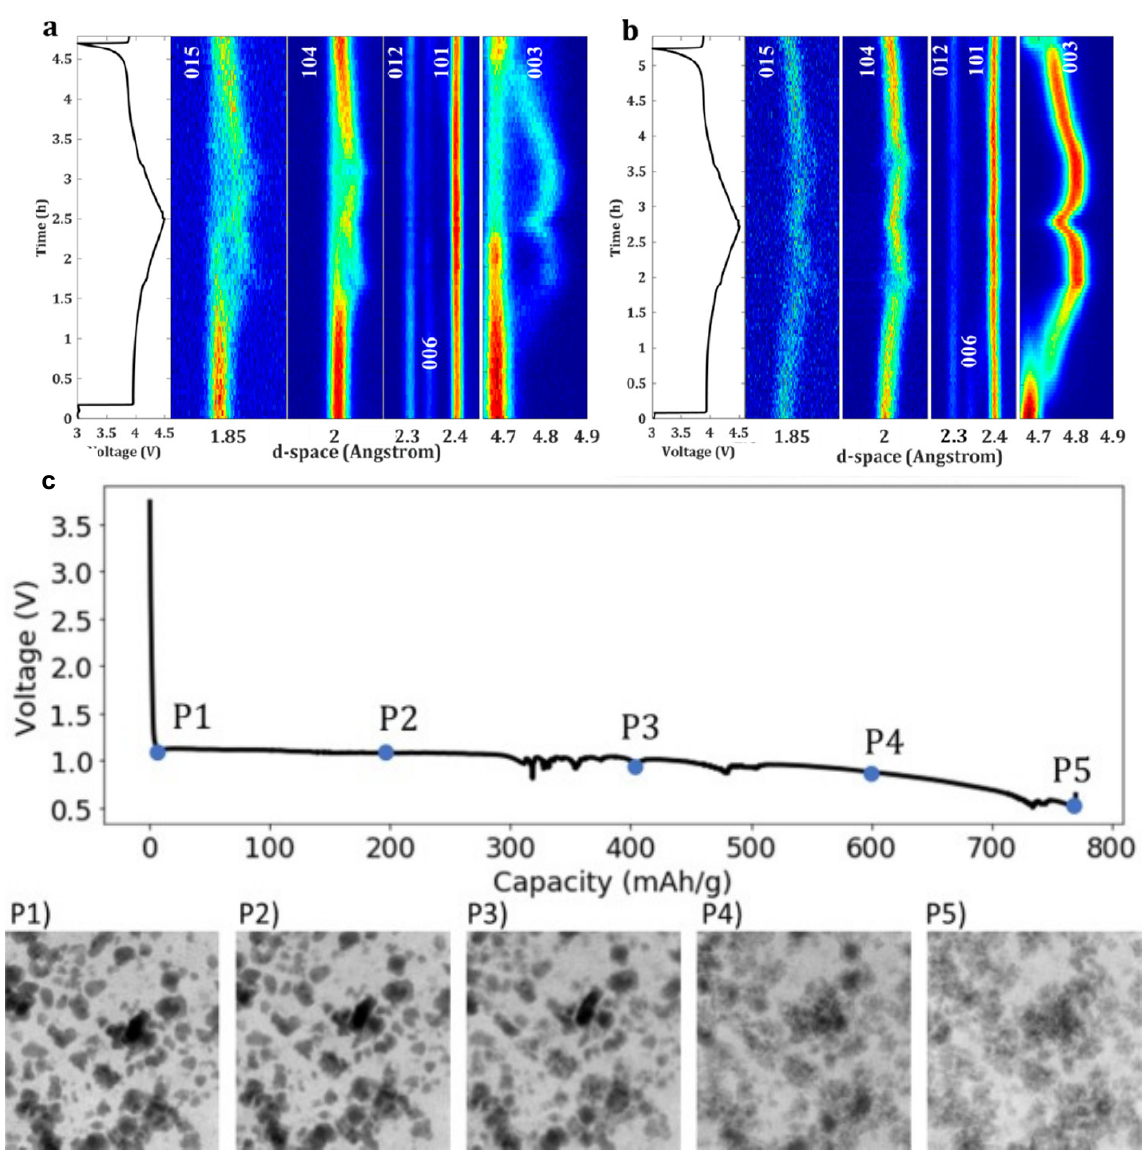
Figure 7. The voltage profiles and the corresponding contour plots showing XRD peak evolution for ( a ) pristine and ( b ) PEDOT-coated LiCoO 2 electrode during one cycle at C/2 with a cutoff voltage at 4.5 V. ( c ) Discharge curve during the over-lithiation test. Five points (P1–P5) were selected to show the respective TXM images [62,63]. Reprint with permission [62]; Copyright 2021, American Chemical Society. Reprint with permission [63]; Copyright 2021, Elsevier.